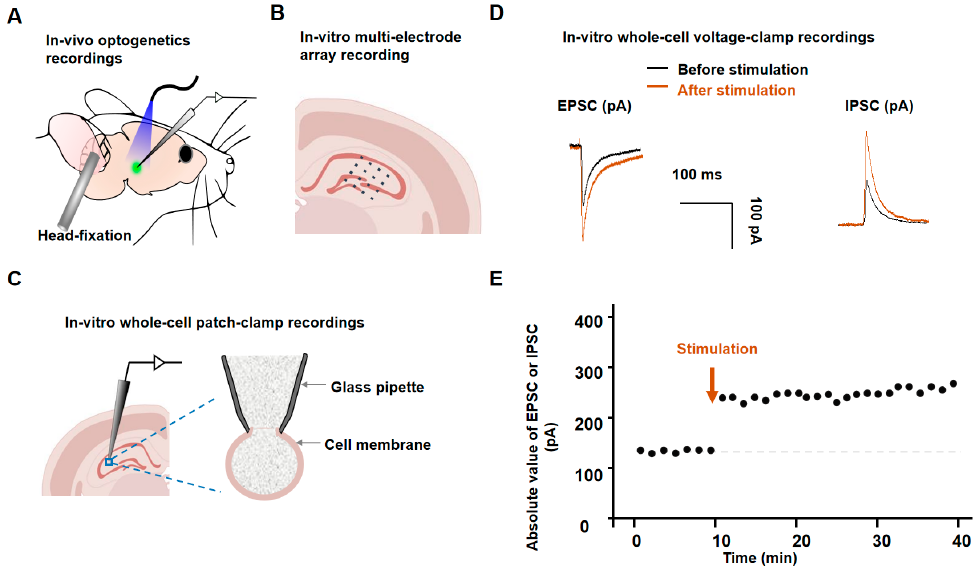
Figure 1. Three types of electrophysiological recordings in long-term potentiation (LTP). ( A ): In vivo optogenetics recordings. ( B ): In vitro electrode array recording. ( C ): In vitro whole-cell patch-clamp recordings. ( D , E ): Traces and normalized slope of excitatory postsynaptic potential or inhibitory postsynaptic current EPSC/IPSC before and after stimulation.